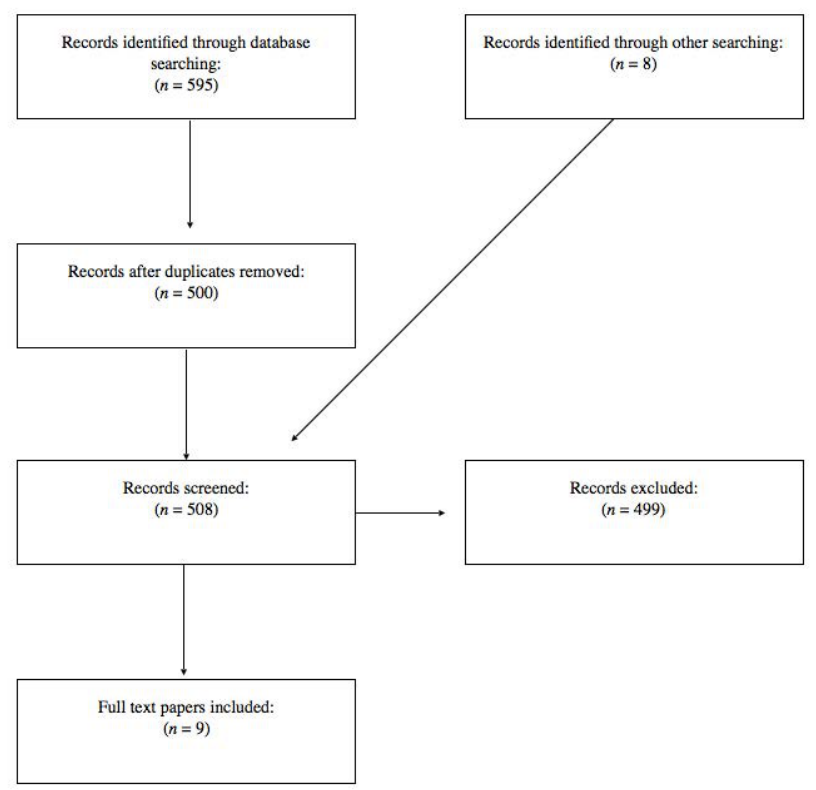
Figure 1. Flowchart depicting the choice of